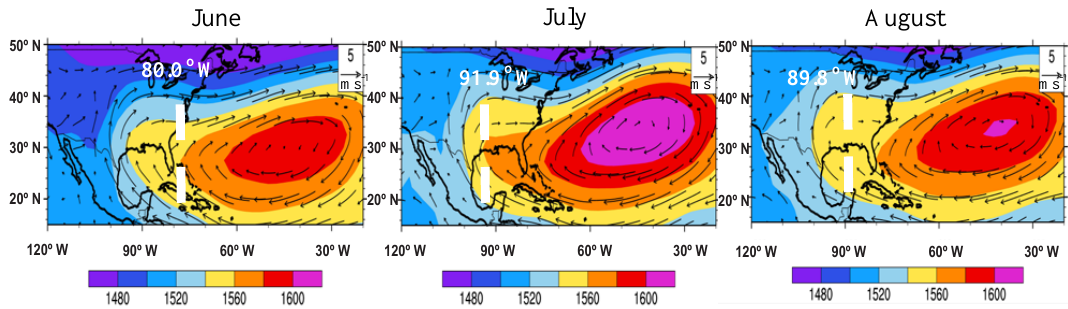
Figure 3. Distributions of the 1998–2013 mean 850hPa geopotential height (color contour) and wind fields (arrows; ms − 1 ) in June (left), July (center), and August (right). The thick white dashed line shows the longitude of the BH-Lon (values shown in white).